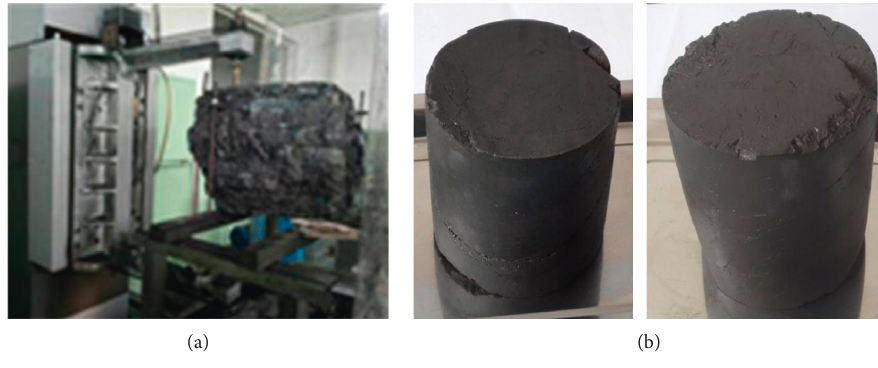
Figure 1: Experimental samples preparation.